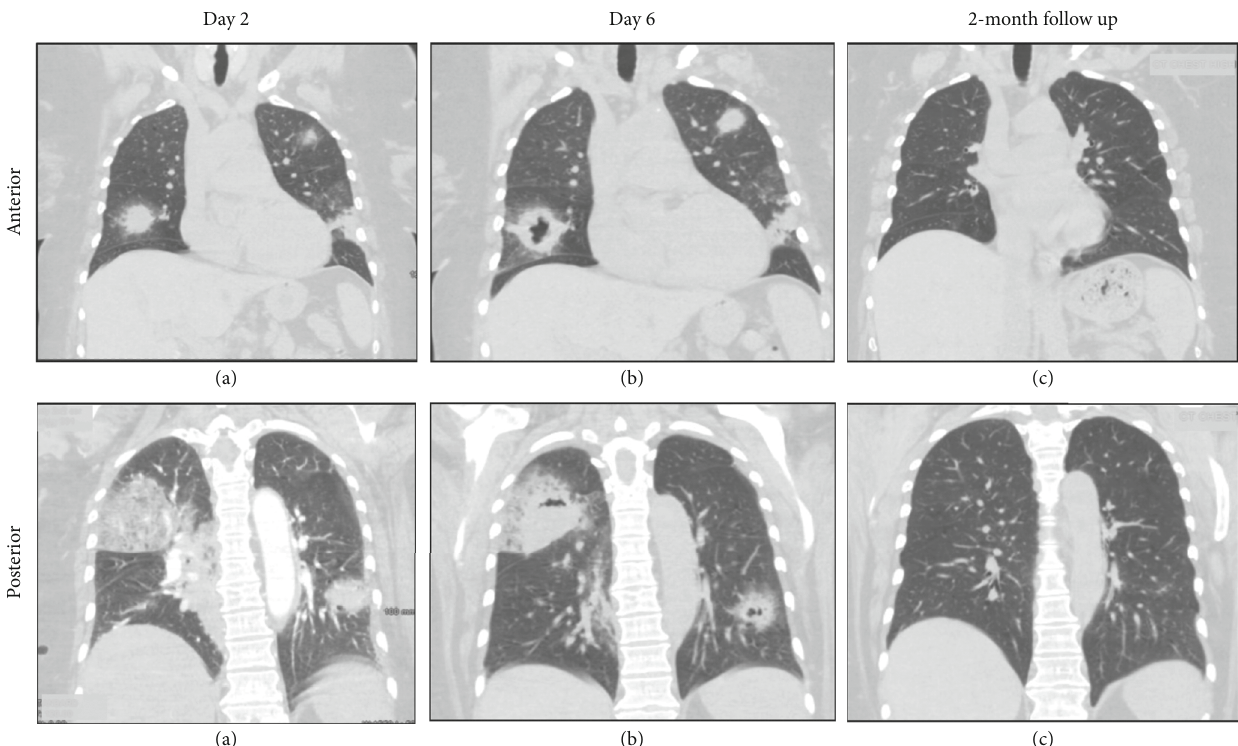
Figure 2: CT chest progression of pulmonary disease in anterior and posterior cuts of the coronal plane demonstrating rapidly cavitating disease. Chronology: (a) 2 days after admission; (b) 6 days after admission; (c) 2-month follow-up